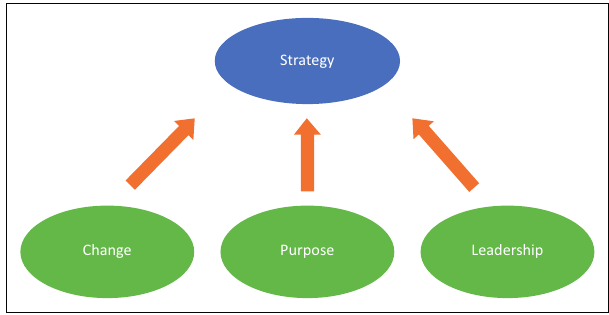
FIGURE 1: Strategy with